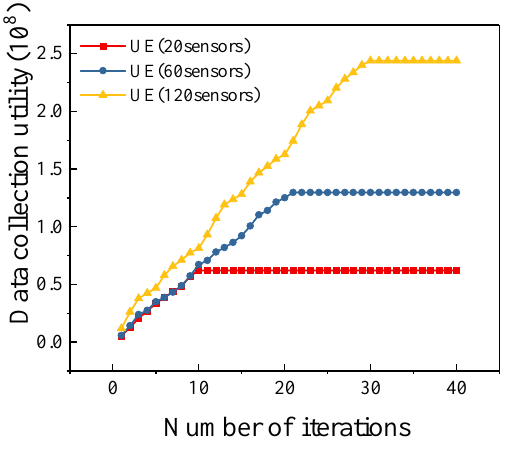
Figure 3. Convergence of UE Algorithm ( n =